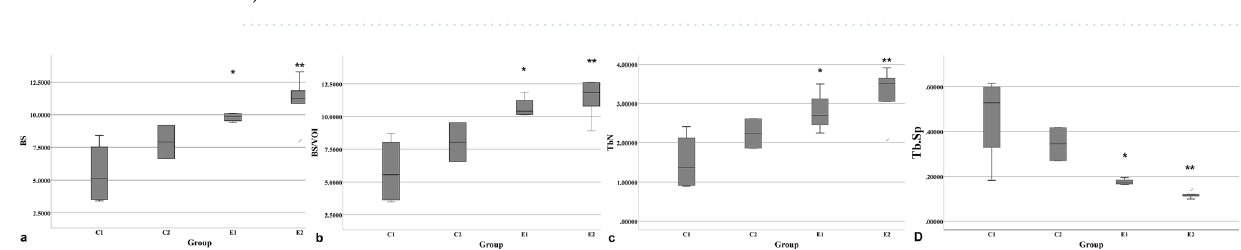
Figure 4. BMD differences between the groups. The E2 group was significantly higher than the C1 group (* p = 0.004) ( a ). The BV and BV/VOI was significantly higher in the E2 group than in the control groups (* p = 0.005, p = 0.003, respectively), while the E1 group showed no significant differences with other groups ( b , c ).